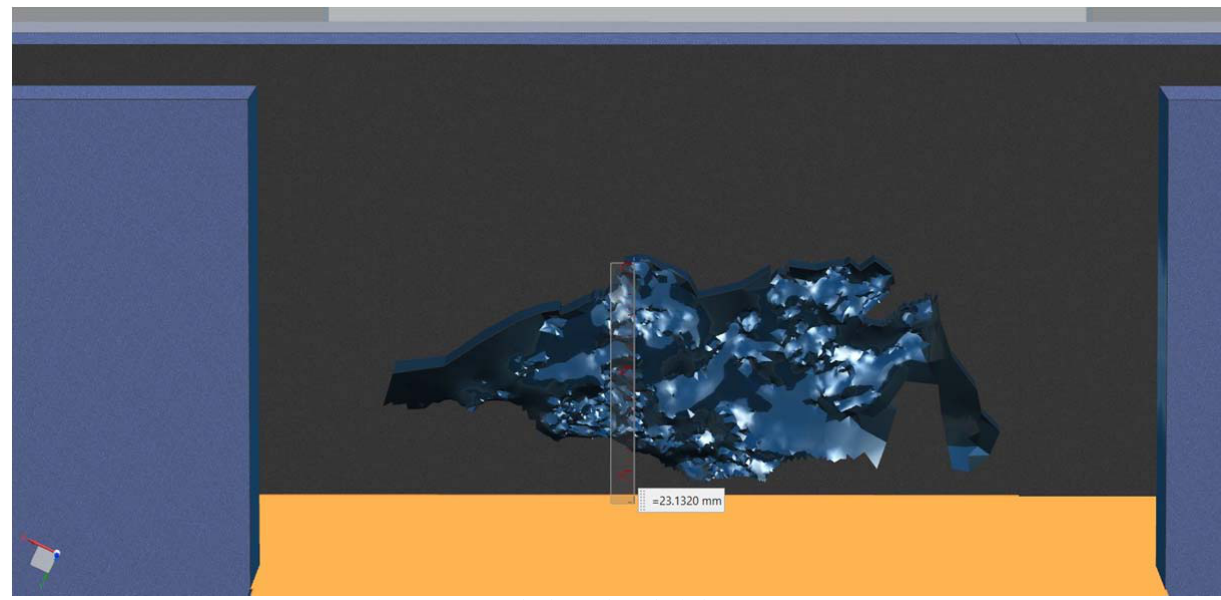
Figure 16. Turbulent flow height